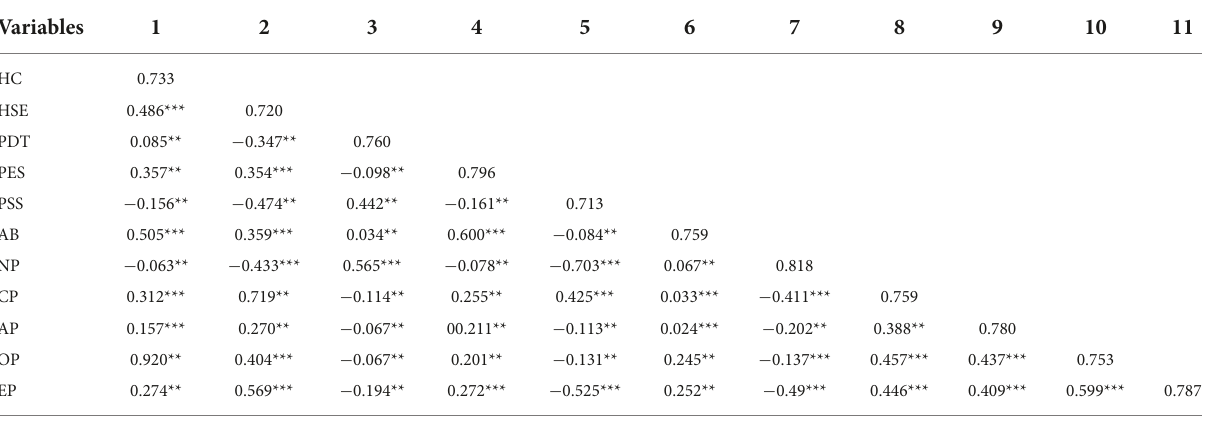
TABLE 4 The correlation coefficients between the variables and their corresponding AVE square roots.